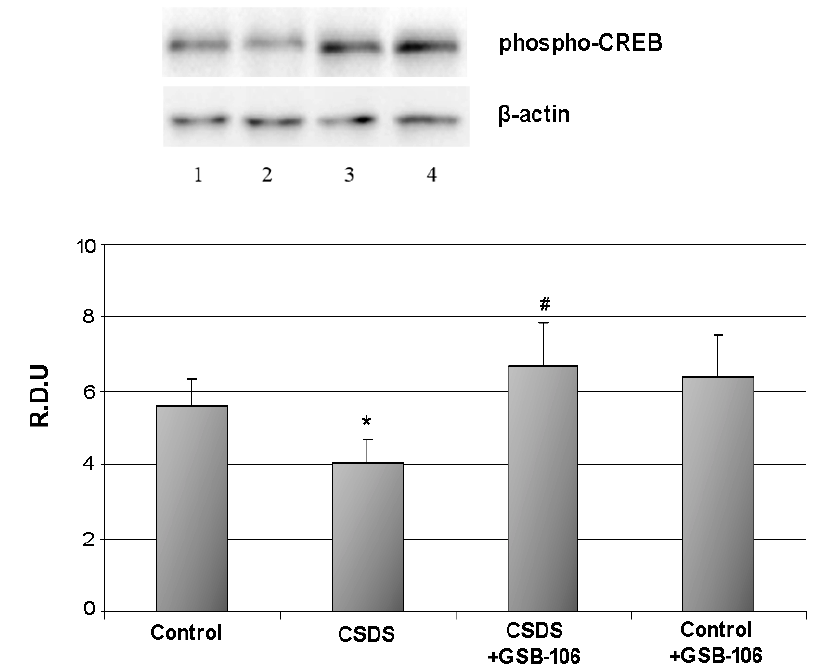
Figure 4. Dipeptide GSB-106 completely restores decreased pCREB level in hippocampus of CSDS mice.Western blot analysis data. R.D.U—relative densitometric units. Lanes: 1—Control, 2—CSDS, 3—CSDS + GSB-106, 4—Control + GSB-106. Data are presented as means and standard errors of the mean. *— p < 0.05 as compared to the “Control “ group, #— p < 0.05 as compared to the “CSDS” group (Mann–Whitney U test). There was no statistically significant difference between the β -actin bands.